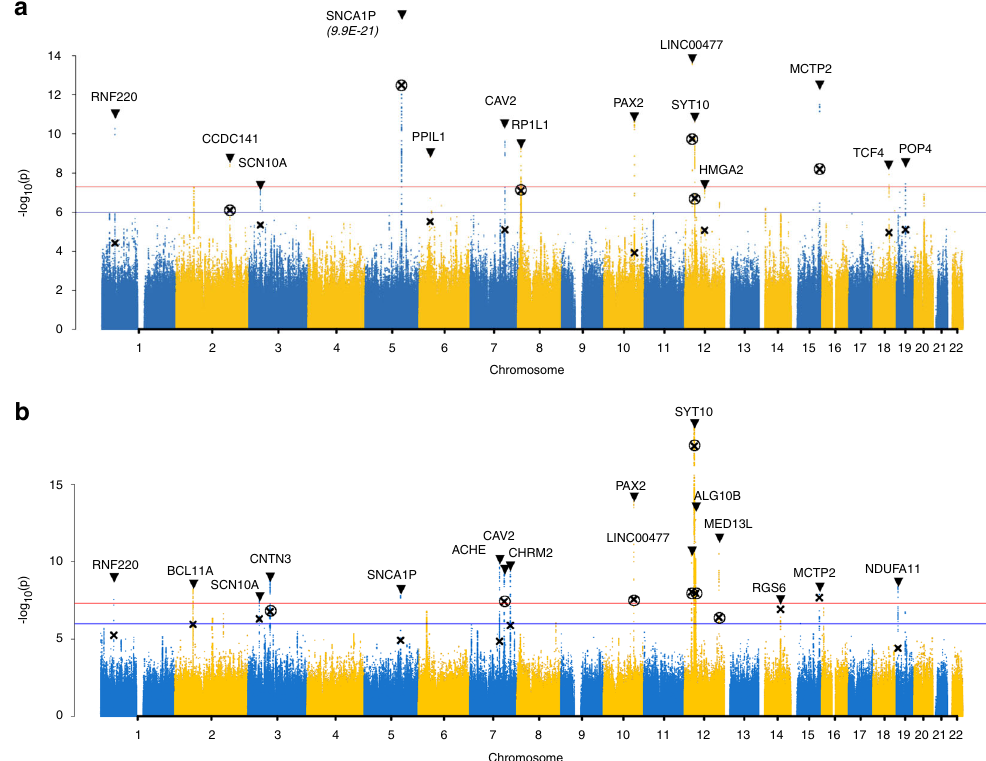
Fig. 2 Manhattan plots of Δ HR ex and Δ HR rec in the full cohort analysis. Genome-wide association study for Δ HR ex ( a ) and Δ HR rec ( b ) in 67,257 individuals in the UK Biobank. P values, expressed as − log10(P), are plotted according to physical genomic locations by chromosome. Lead SNPs are marked by the triangles. The crosses indicate the P values of these SNPs in the discovery data set. Crosses are encircled for SNPs that formally replicated. Locus names of the novel loci correspond to the nearest annotated gene. The blue horizontal line indicates a P value threshold of 1 × 10 − 6 , corresponding to the lookup signi fi cance threshold. The red horizontal line indicates a P -value threshold of 5 × 10 − 8 , corresponding to genome-wide signi fi